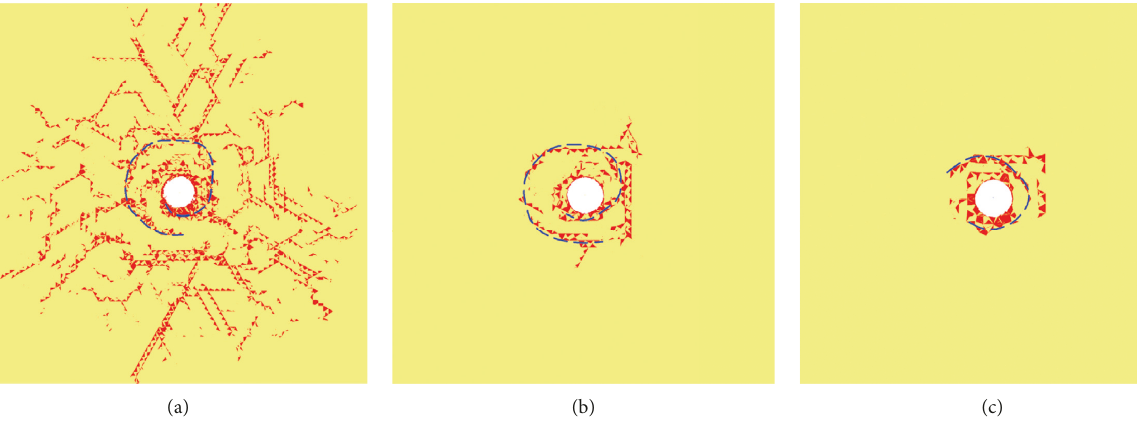
Figure 10: Fracture distribution around the roadway boundary using different sizes of tetrahedral block: (a) block with 0.6m edge length; (b) block with 0.8m edge length; (c) block with 1m edge length.